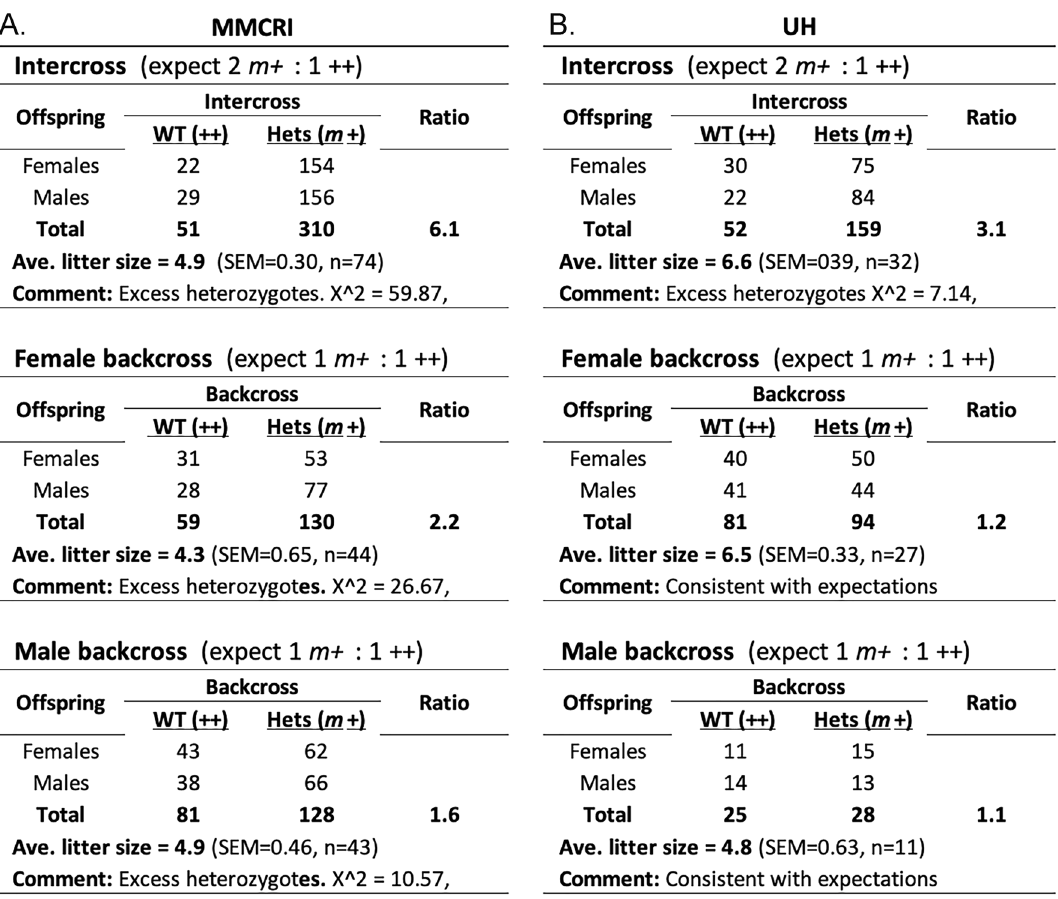
Figure 2. A1cf segregation in in vivo test and control crosses. A1cf genotype segregation is shown for two study locations: the Maine Medical Center Research Institute (MMCRI, panel A ) and the University of Hawaii (UH, panel B ). ++ refers to the wild-type genotype and m + to the heterozygous genotype. Homozygotes were not found in either intercross. c 2 goodness-of-fit tests are shown with point-wise p -values; results remain significant after correcting for testing multiple hypotheses. ‘Comment’ refers to test results for the fit between total observed genotype numbers with Mendelian expectations for wild-type and heterozygous mice. Sex ratios did not differ significantly from 1:1 expectation (not shown). SEM, standard error of the mean; n, total number of